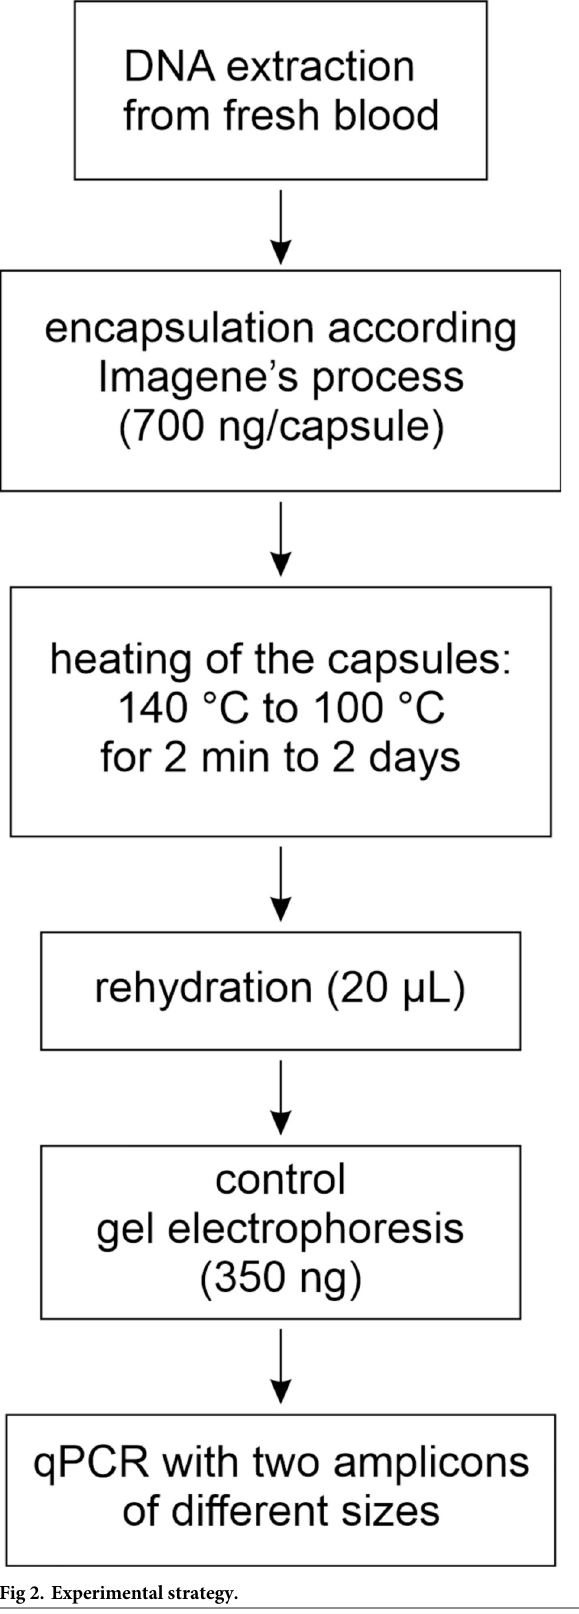
Fig 2. Experimental